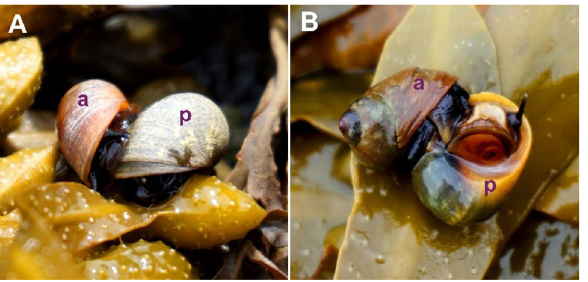
Figure 1. Littorina obtusata pair in copulation. ( A ) Typical position of copulating snails on the substrate. ( B ) A turned pair with an inserted penis visible. a—active partner (inserting penis); p—passive partner (accepting